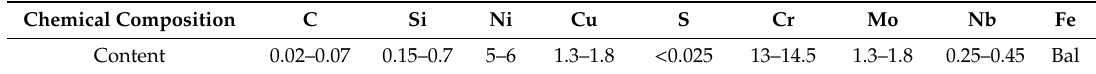
Table 1. Chemical composition of FV520B-I (wt%).